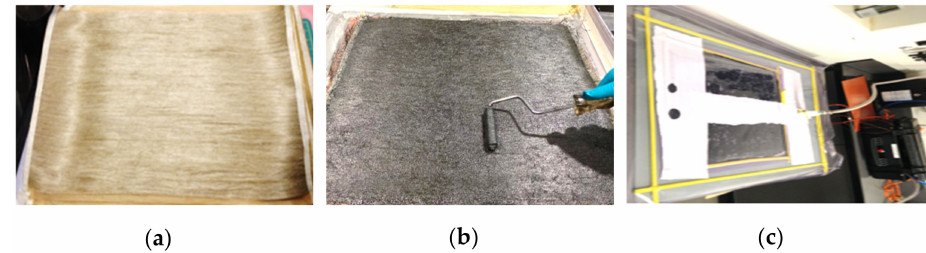
Figure 1. ( a ) Unidirectional flax fibers. ( b ) Wetting the fibers. ( c ) Vacuum bagging.